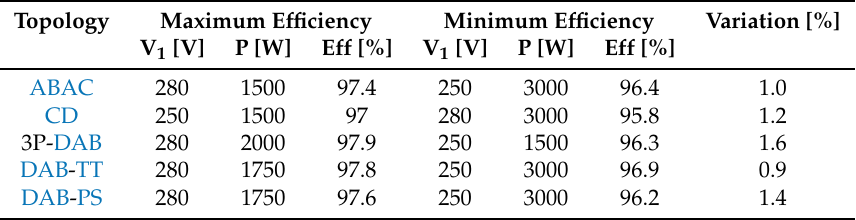
Table 7. Maximum and minimum nominal output voltage efficiency map values in buck mode. Topology